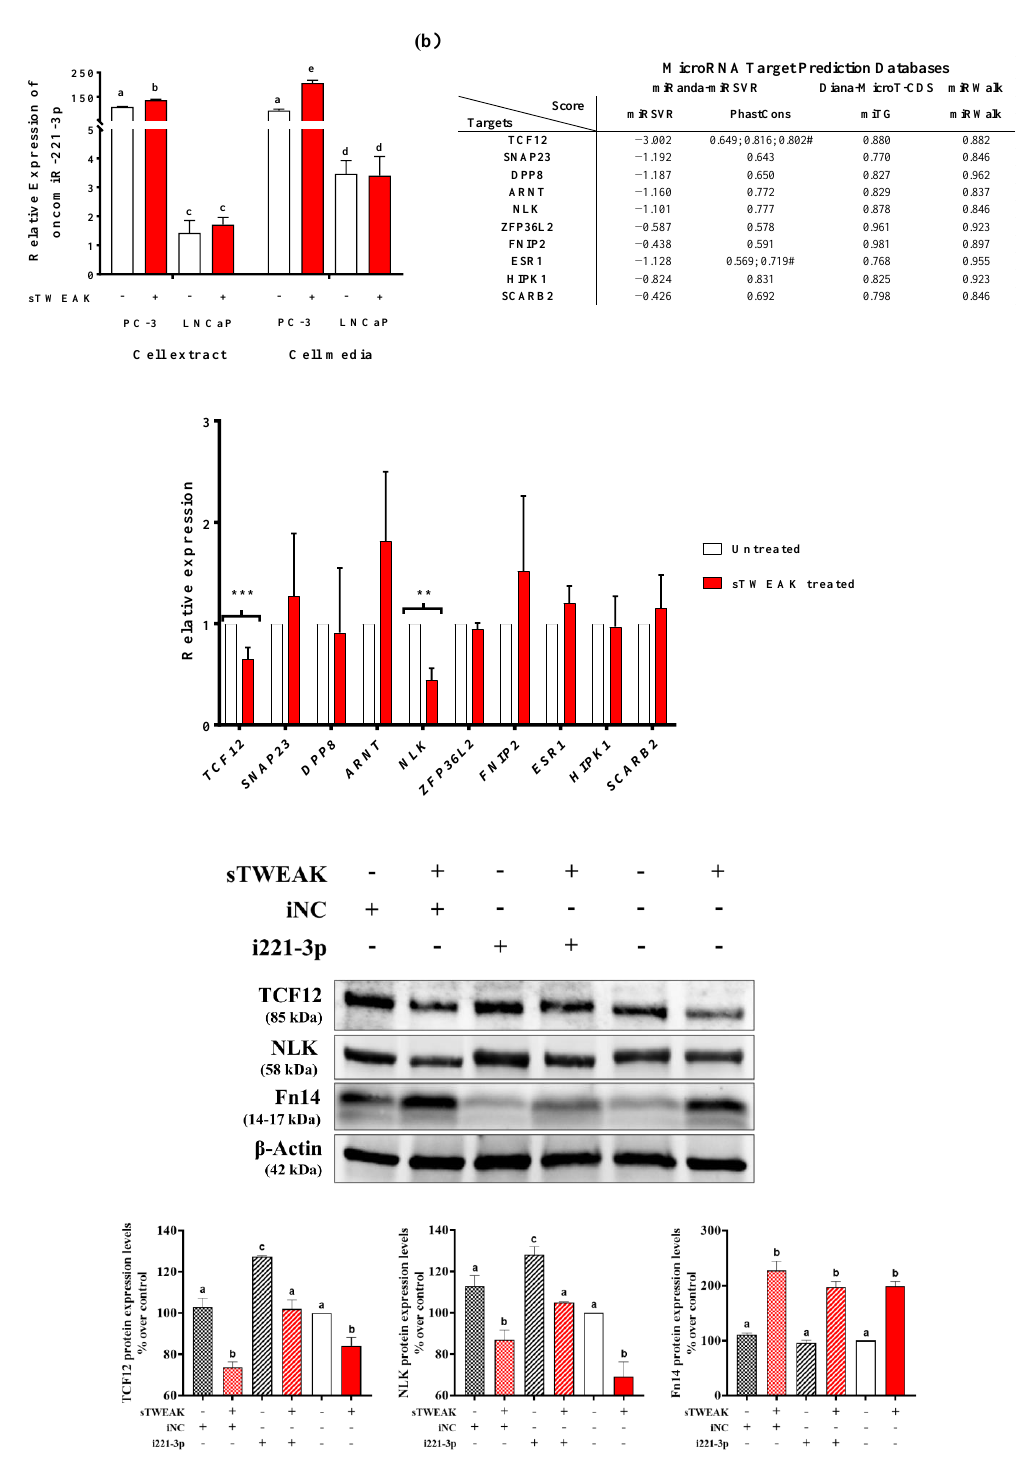
Figure 4. sTWEAK regulates oncomiR-221-3p expression and down-regulates NLK and TCF12 targets. ( a ) oncomiR-221-3p expression in PC-3 and LNCaP cell extracts and in extracellular vesicles (EVs) isolated from cell media. Different lettering over boxes indicates statistical differences. Significant differences are established at p < 0.05. Data are expressed as mean ± SEM ( n = 4 experiments). ( b ) Selected targets for oncomiR-221-3p by 3 different target prediction algorithms. # conserved elements in multiply-aligned sequences. ( c ) qRT-PCR mRNA expression of selected oncomiR-221-3p targets in PC-3 cells before and after treatment with sTWEAK. Significant differences: ** p < 0.01; *** p < 0.001. Data are expressed as mean ± SEM ( n = 6